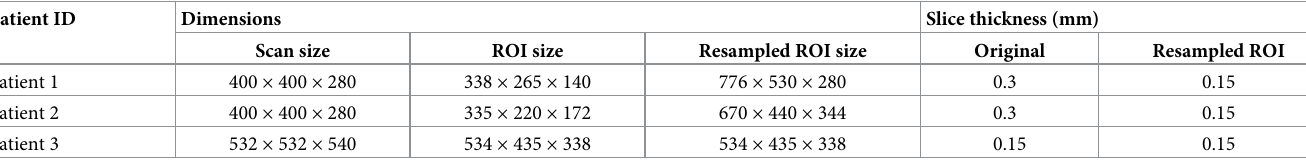
Table 1. Detail of the utilized